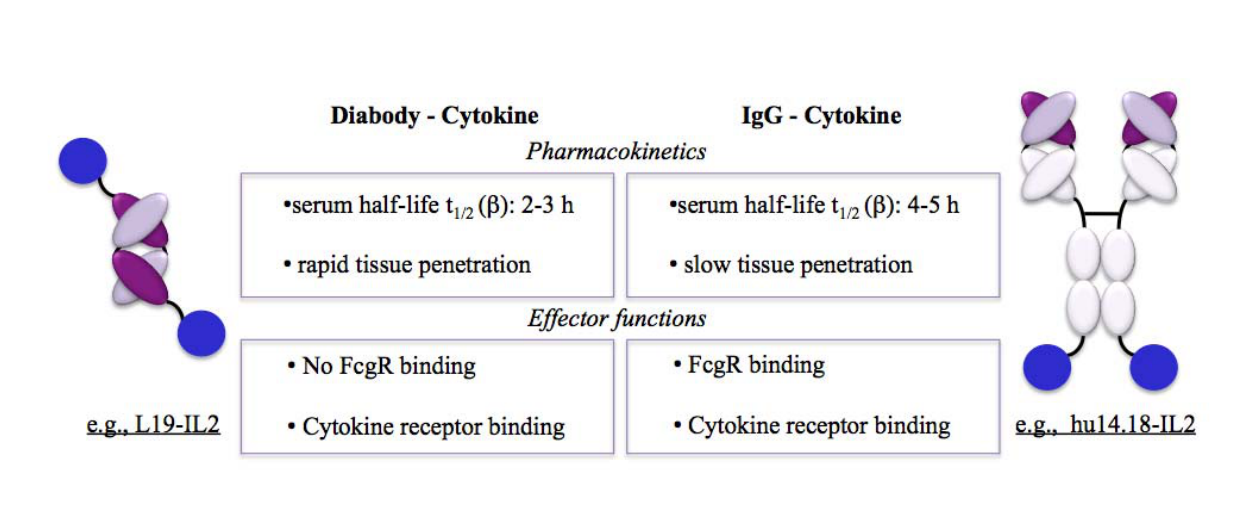
Figure 2. Comparison of the antibody formats of clinical stage